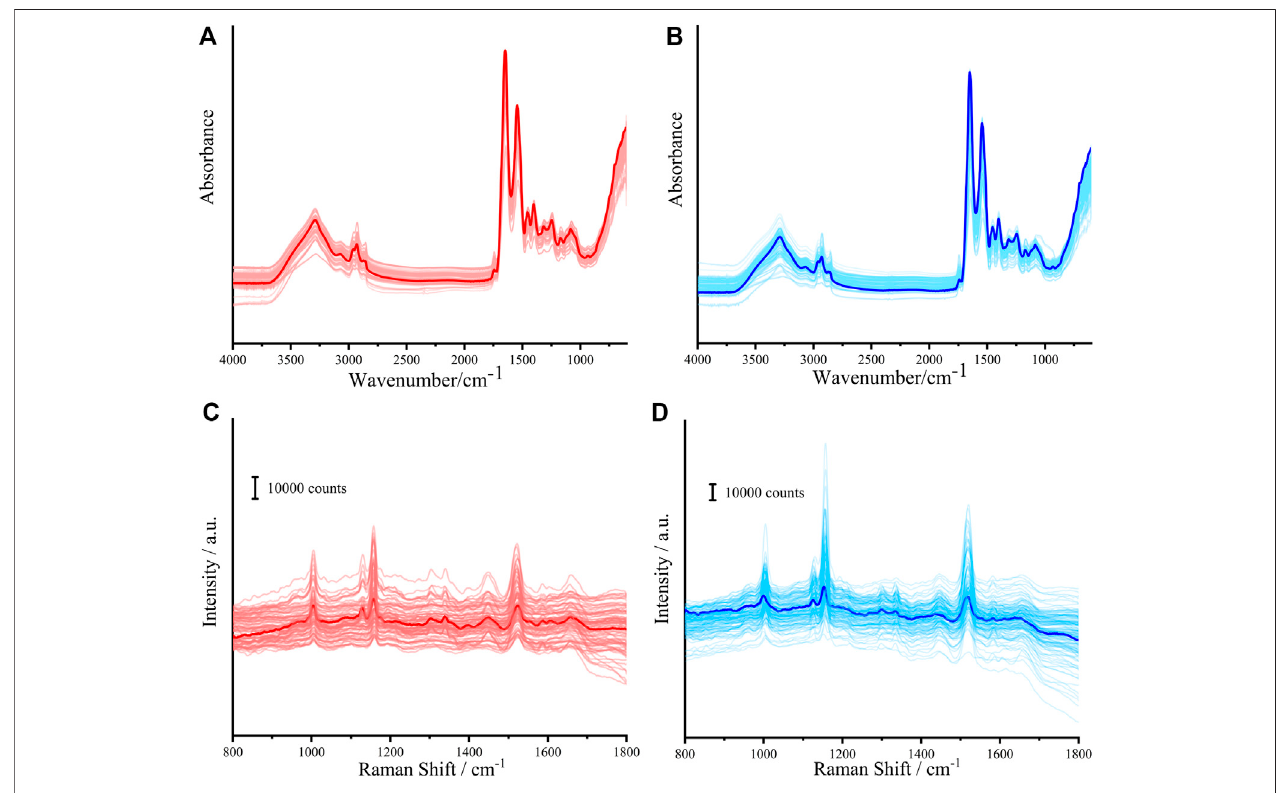
FIGURE 1 | FTIR spectra of serum from patients with lung cancer (A) and healthy people (B) . Raman spectra of serum from patients with lung cancer (C) and healthy people (D) . (The corresponding average spectra are shown in bold).